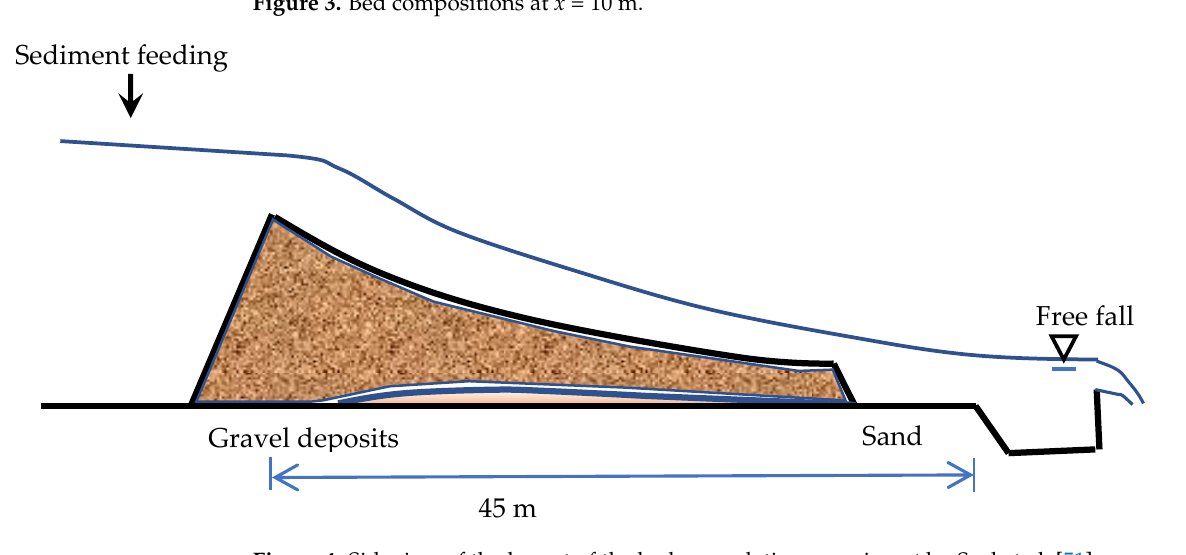
Figure 4. Sideview of the layout of the bed-aggradation experiment by Seal et al. [51]. Table 2. Input sediment mixture for the bed aggradation experiment (Seal et al.